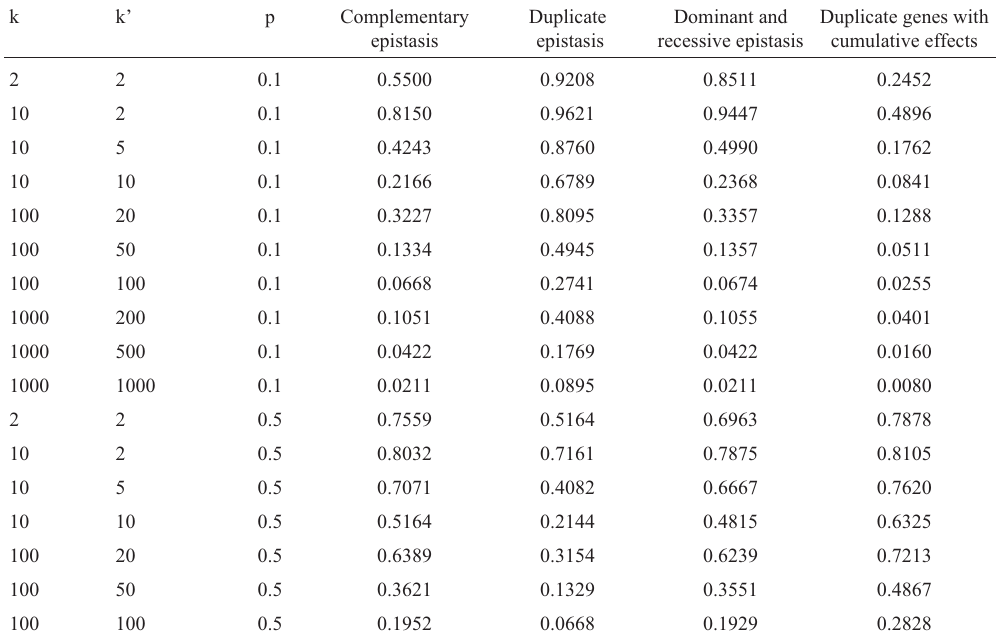
Table 2 - Correlation values between the number of genes that increase the trait expression and the genotypic value of the individual, considering four typesofepistasis,fordifferentpolygenicsystems(kisthenumberofgenesandk’isthenumberofgenesthatinteract)andpopulations(pisthefrequency of the dominant genes). k’ p Complementary Duplicate epistasis